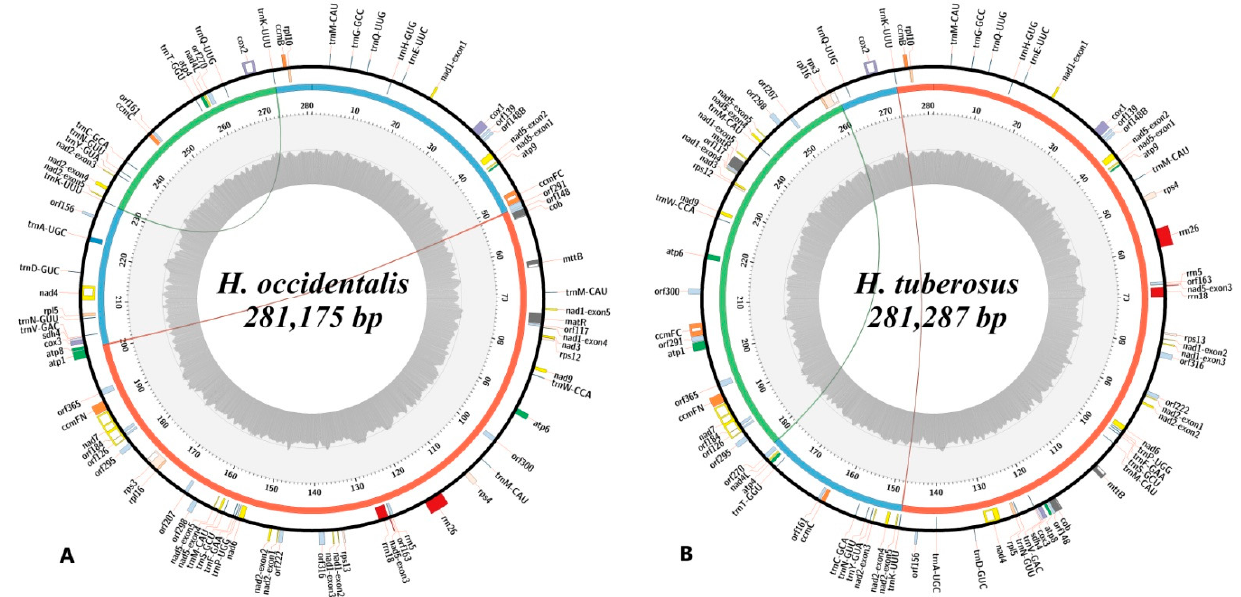
Figure 1. Genetic maps of the H. occidentalis ( A ) and H. tuberosus ( B ) mitogenomes. Colored blocks on circular axis denote genes, and white blocks denote introns. The gray histogram on the inner ring shows the guanine-cytosine (GC) content as percent of GC nucleotides in 100 bp sliding window, the dark gray line denotes 50% GC content threshold. Arcs indicate repeats associated with structural variants that could form subrings indicated by arcs and red, blue, and green regions on the middle ring of the figure.